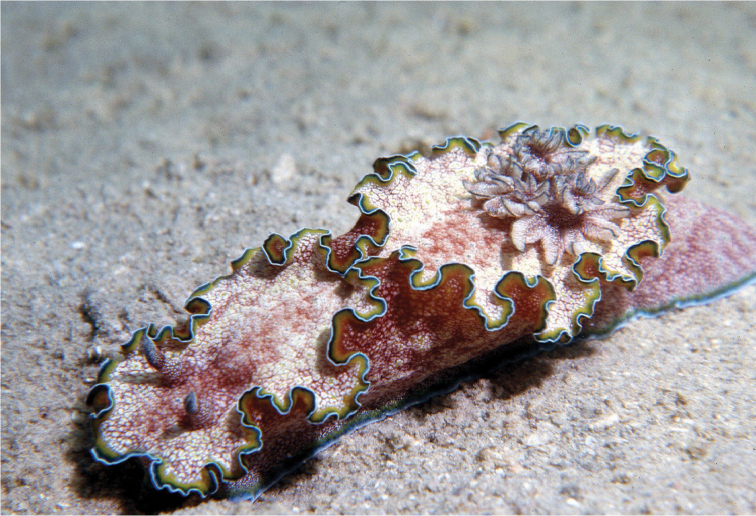

Glossodoris
cincta (Bergh, 1888), photograph E Pridgen.